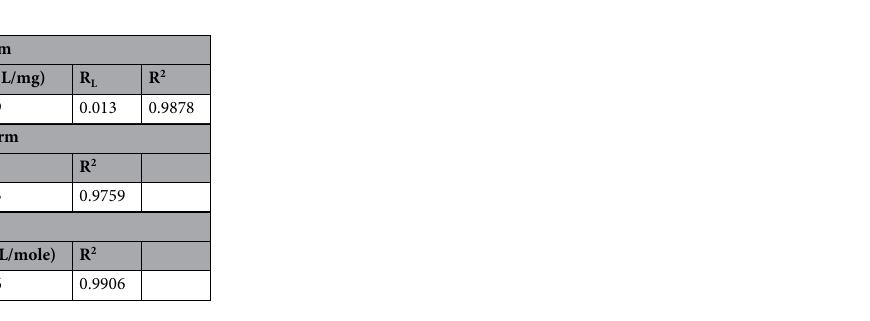
Figure 9. Plots of adsorption isotherms for the adsorption of MB dye by 50 mg of AC500/NZ at 25 °C and initial pH of the solution 7; ( A ) Langmuir isotherms model, ( B ) Freundlich isotherms model and ( C ) Temkin isotherms model.